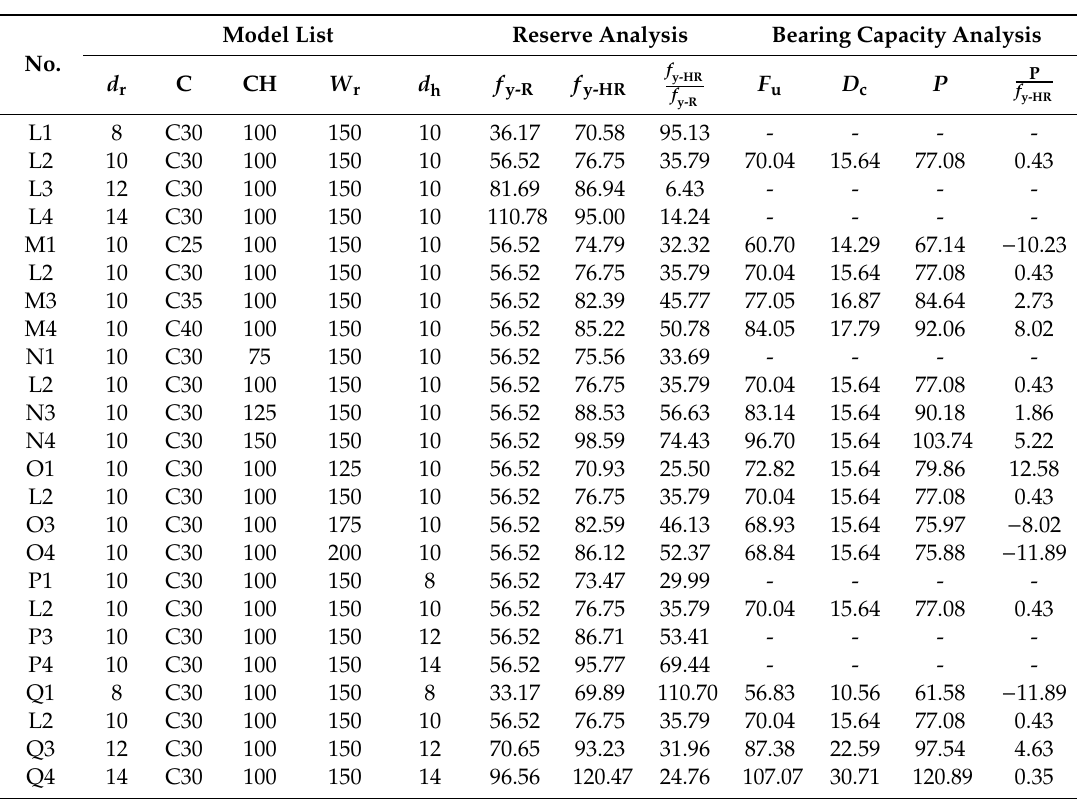
Table 4. Bearing capacity analysis and model